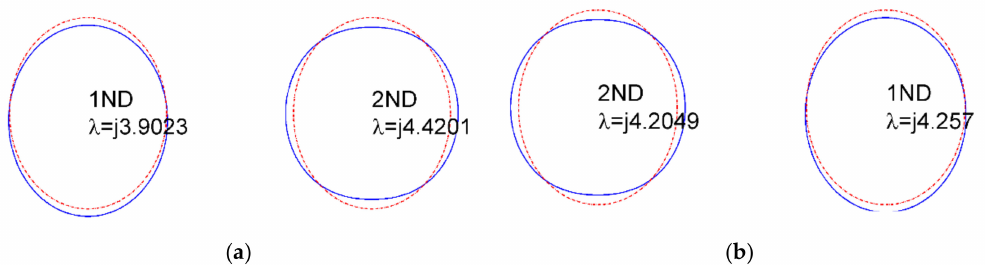
Figure 4. Frequency veering with vibration mode exchange between ( a ) ω = 3.4 and ( b ) ω = 3.6. The dash and solid lines denote the original position and vibration modes,